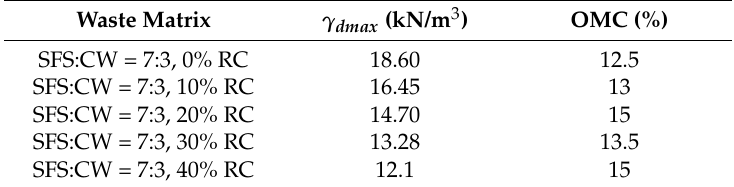
Table 1. The maximum dry density of the waste matrix decreases as the rubber content increases due to the relatively low unit weight of rubber. Table 1. Optimum moisture content and maximum dry density of the waste